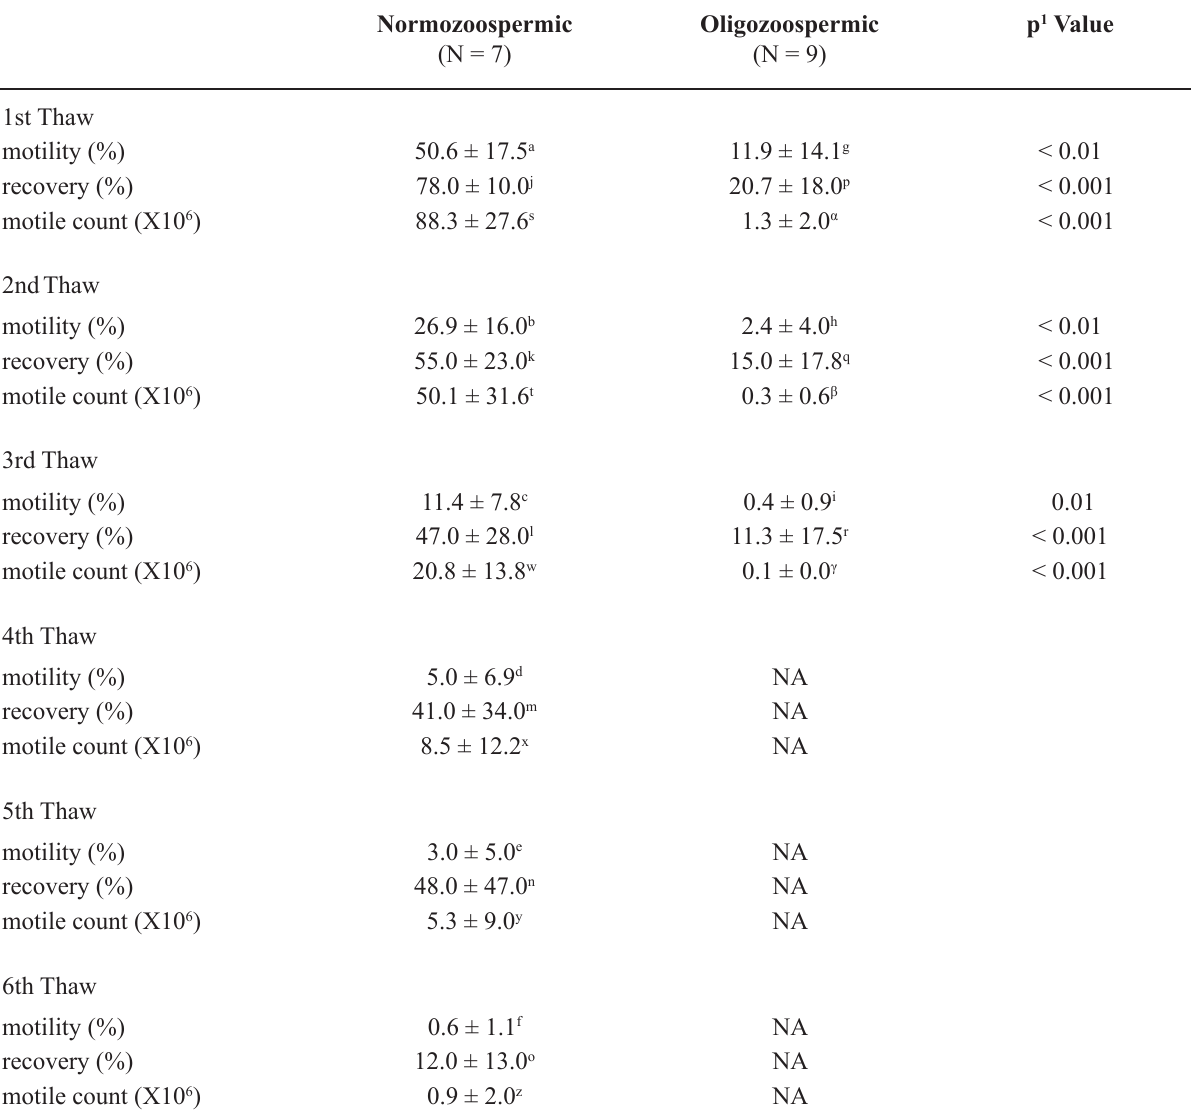
Table 2 – Percentage motility, percentage recovery for motility between thaws and number of total motile sperm after each thaw in both normozoospermic and oligozoospermic groups after repeated thaw-refreezing. Values are mean ±